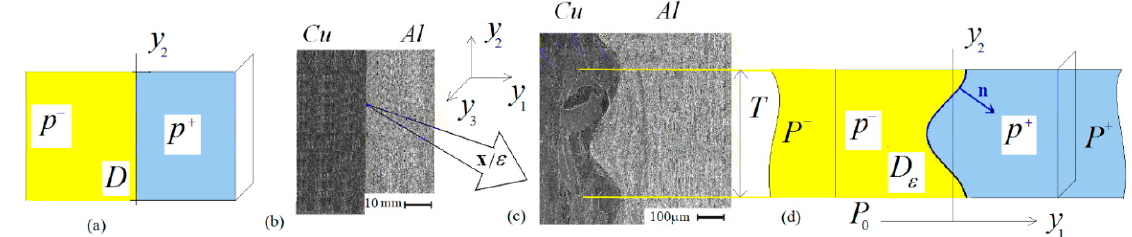
Figure 1. The explosion weld: ( b ) macroscopic view, ( c ) microscopic view, ( a , d ) models (macroscopic and microscopic).